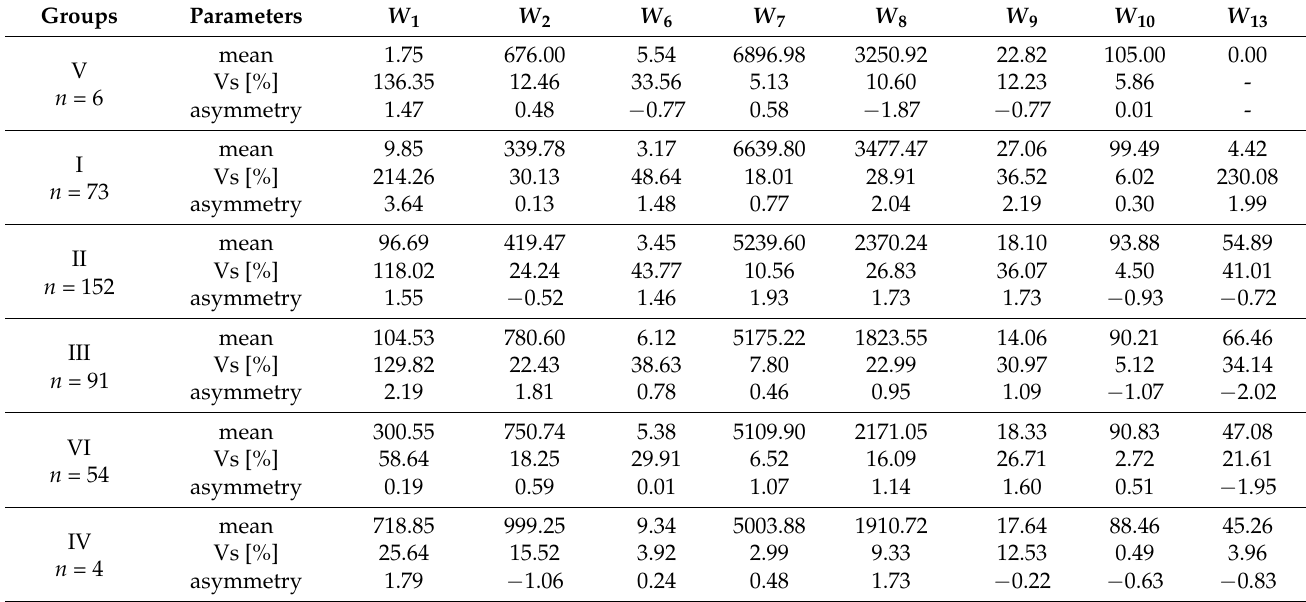
eters characterizing the average level, differentiation, and asymmetry of the distribution of indicators in individual groups of poviats are presented in Table 2. Table 2. Parameters of the distribution of the values of indicators in groups of poviats ordered in ascending order according to the average values of the indicator W 1